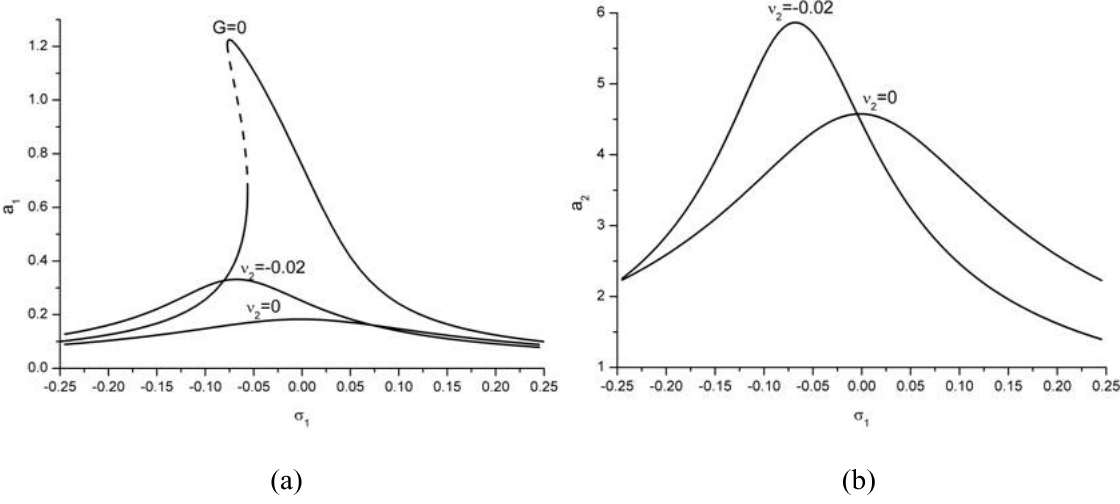
Fig. 7. Effect of detuning the absorber’s frequency on the frequency-response curves of (a) the plant and (b) the absorber when f = 0 . 025 , G = 0 . 01 and ζ = 0 . 02 . following discussion, the case σ 1 = − 0 . 1 is